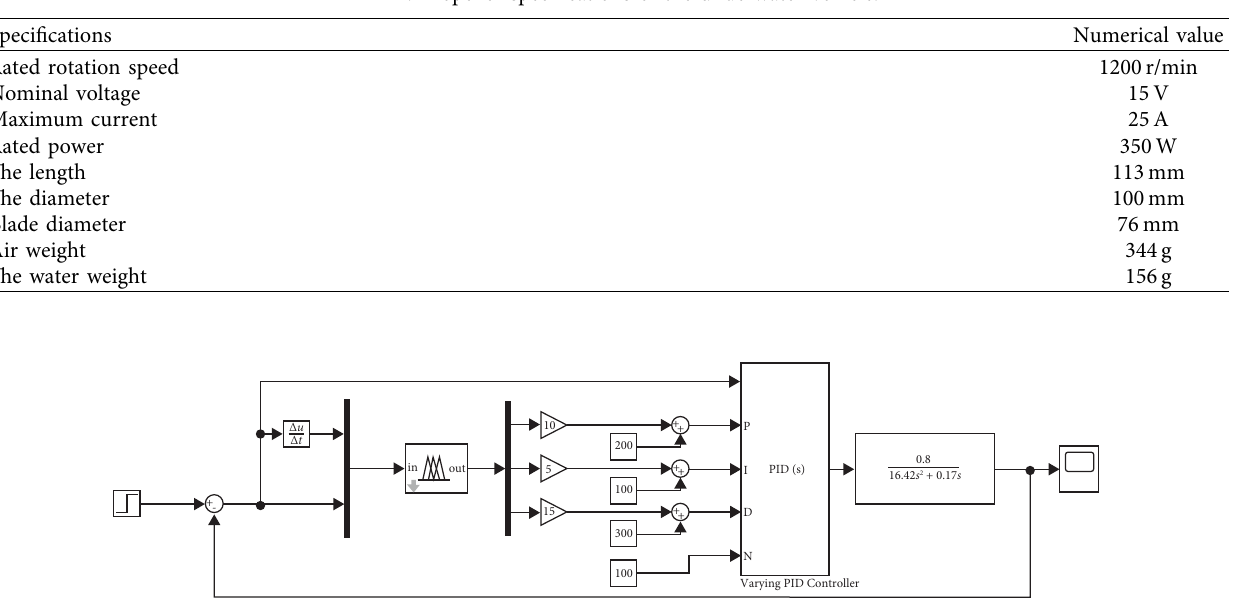
Table 3: Fuzzy rules table ∆ k